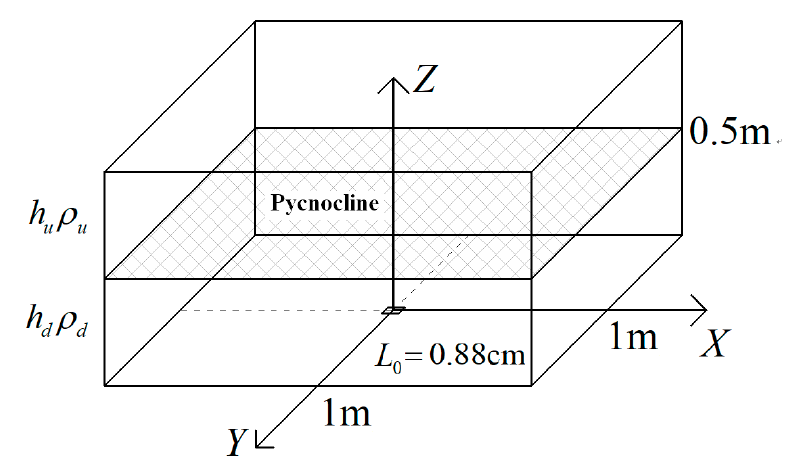
Figure 2. Schematic diagram of the turbulent jet in a stratified fluid.